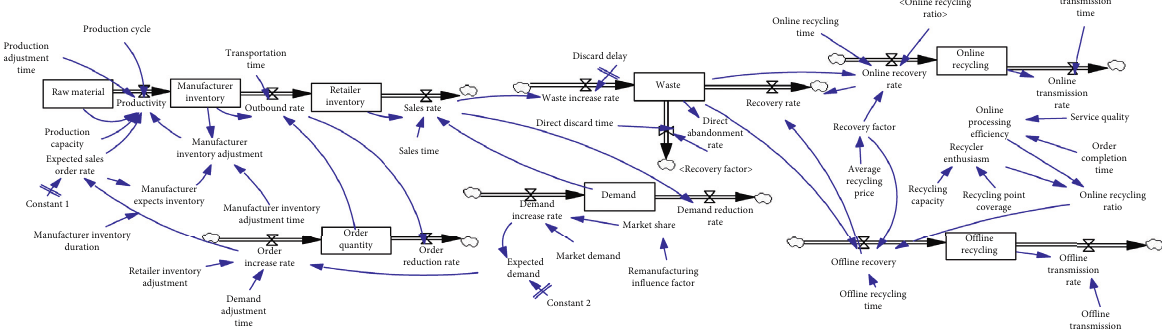
Figure 4: System dynamics mode for O2O